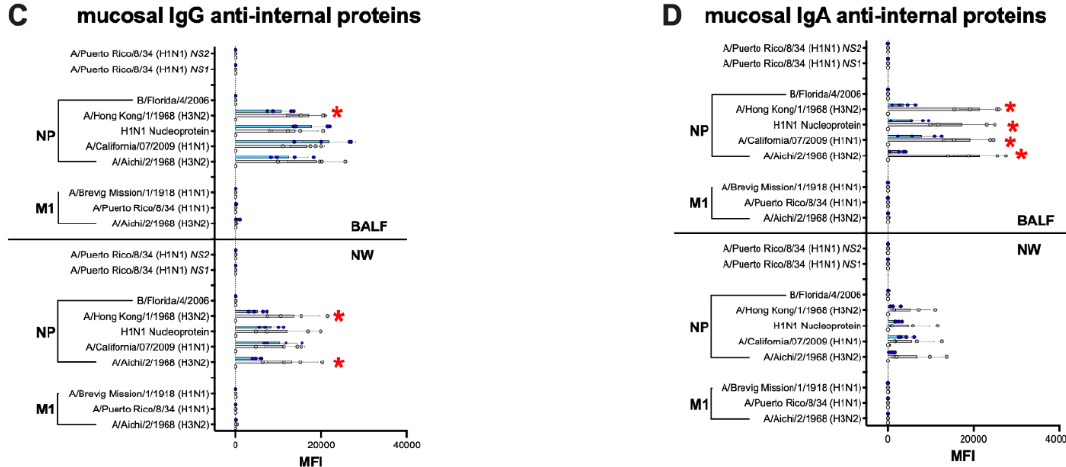
Figure 10. Mucosal antibody responses against NA and IAV internal proteins. The same set of samples from Figure 8 were probed for anti-NA ( A ) IgG and ( B ) IgA antibodies as well as anti-IAV internal protein ( C ) IgG and ( D ) IgA antibodies. NW, nasal washes. Insets correspond to combined BALF and NW data in which each dot corresponds to the average reactivity of each sample against anti-IAV internal proteins in the array. ( B , C ) a Data on N1 NA A/Egypt/2321NAMRU3/2007 (H5N1) antigen was not used for analyses due to high background. The statistically significant differences between IGIP-H1att and caLen are depicted with red asterisks.